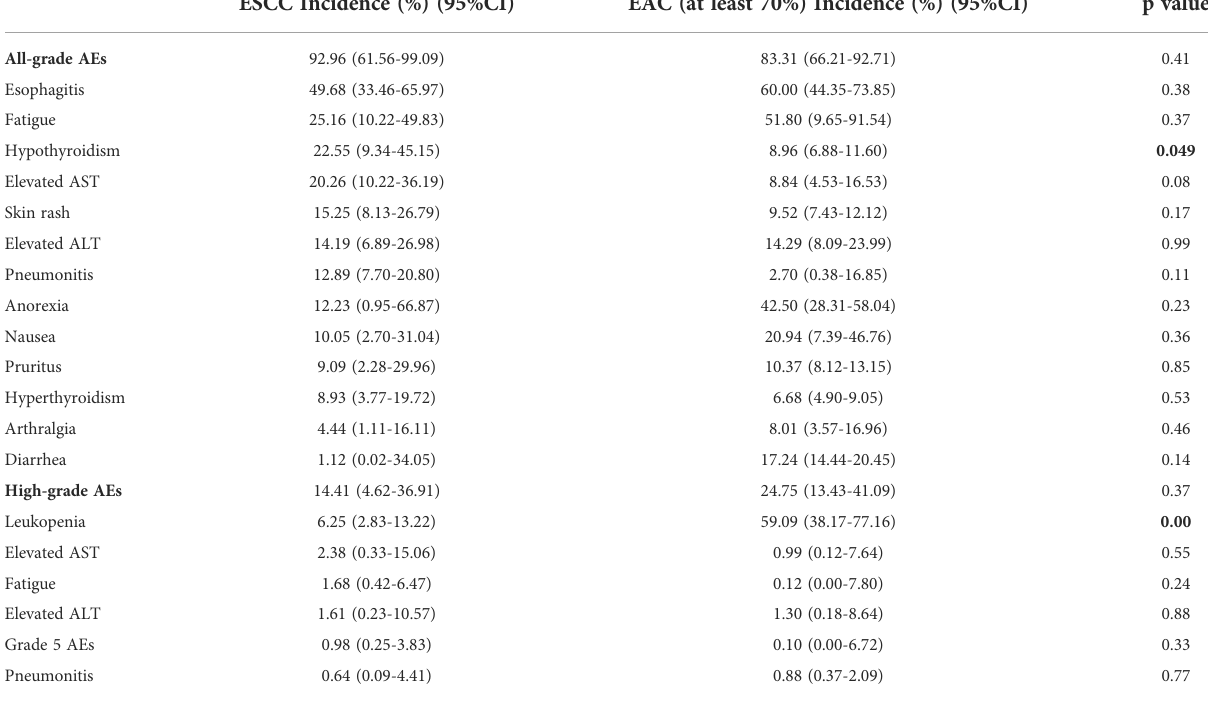
TABLE 5 Differences in the incidence of AEs with ESCC vs EAC